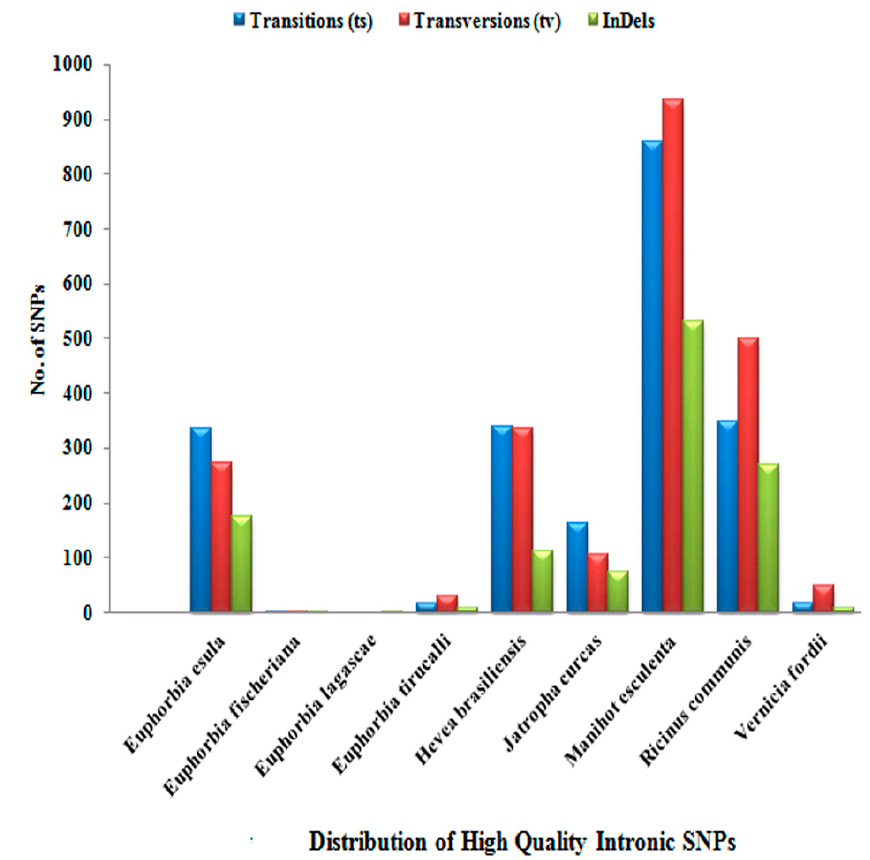
Figure 3. Distribution of high-quality intronic single-nucleotide polymorphisms (SNPs). The details of nucleotide substitutions of all of the nine selected species belonging to the family Euphorbiaceae are shown in Supplementary Table S3 and Figure 4. The fre- quency of C ↔ T mutation (transition) was observed to be higher in all members of Eu- phorbiaceae, while in the case of transversion, the A ↔ T ratio was found to be most abun- dant, and among the indels, (A/ − , − /A) was found to be more abundant.